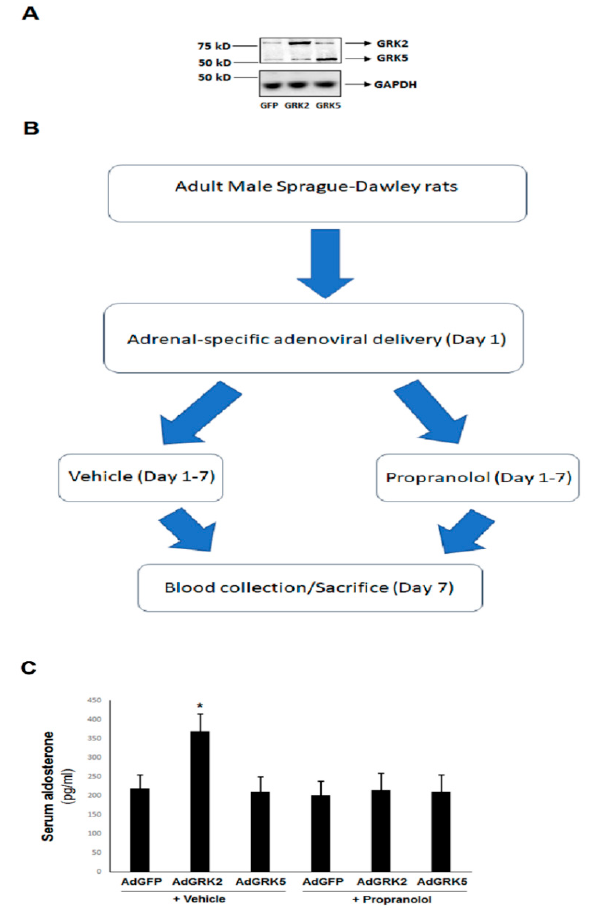
Figure 4. β AR-induced GRK2, but not GRK5, is essential for adrenal aldosterone production in vivo. ( A ) Representative western blots in protein extracts from the adrenal glands from AdGFP (GFP)-, AdGRK2 (GRK2)-, or AdGRK5 (GRK5)-treated healthy adult rats, at 7 days post in vivo gene transfer, confirm the overexpression of the respective transgenes. Glyceraldehyde 3-phosphate dehydrogenase (GAPDH) is also shown as a loading control. ( B ) A flowchart of the in vivo procedural sequence. ( C ) The circulating aldosterone levels in the rats treated with 100 mg / kg / day propranolol or vehicle (in drinking water) for seven consecutive days. *, p < 0.05, vs. any other group; n = 5 rats /